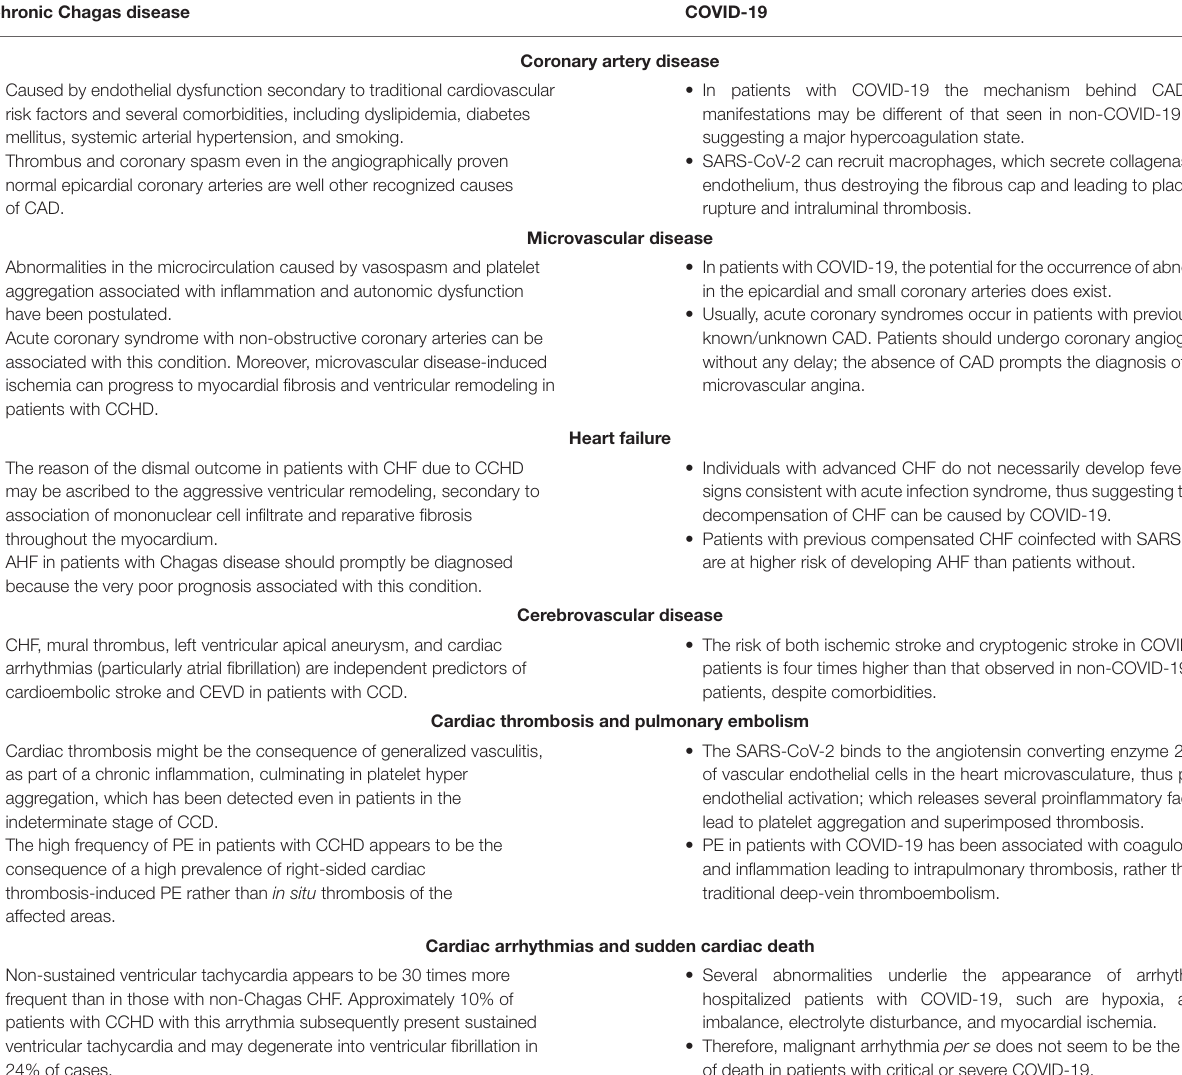
TABLE 1 | Cardiovascular implications in patients with Chagas disease and